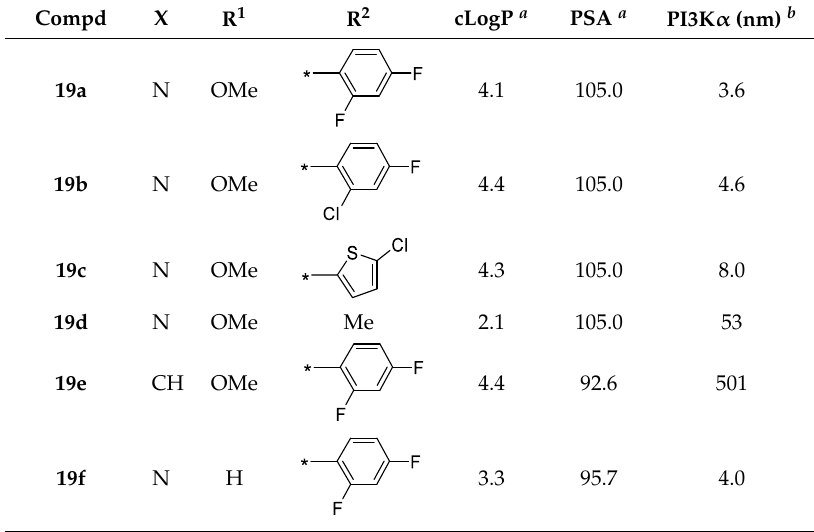
Table 2. Enzymatic inhibition by compound 19a a